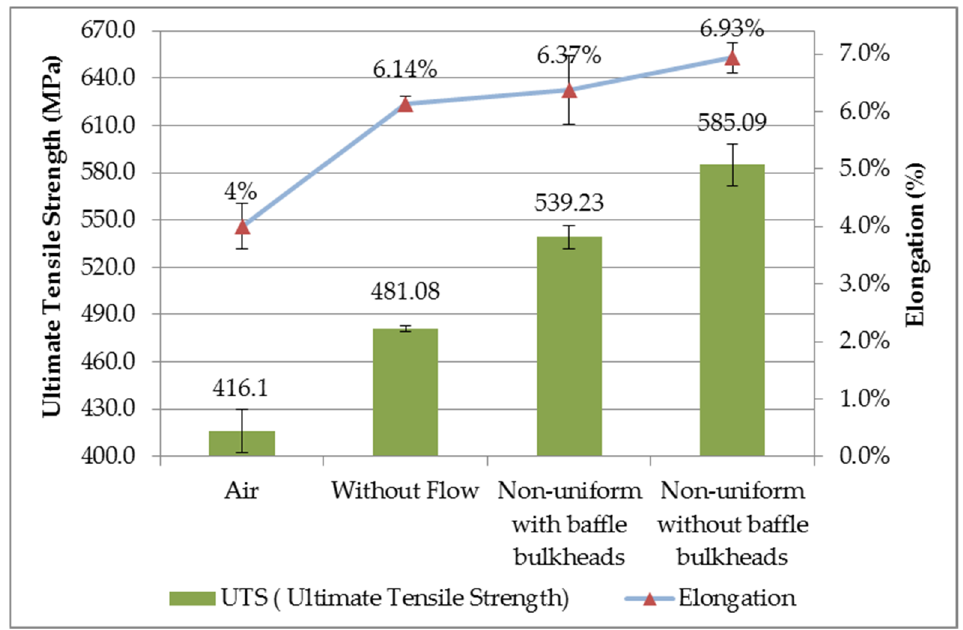
Figure 7. Results of the tensile strength and elongation tests.